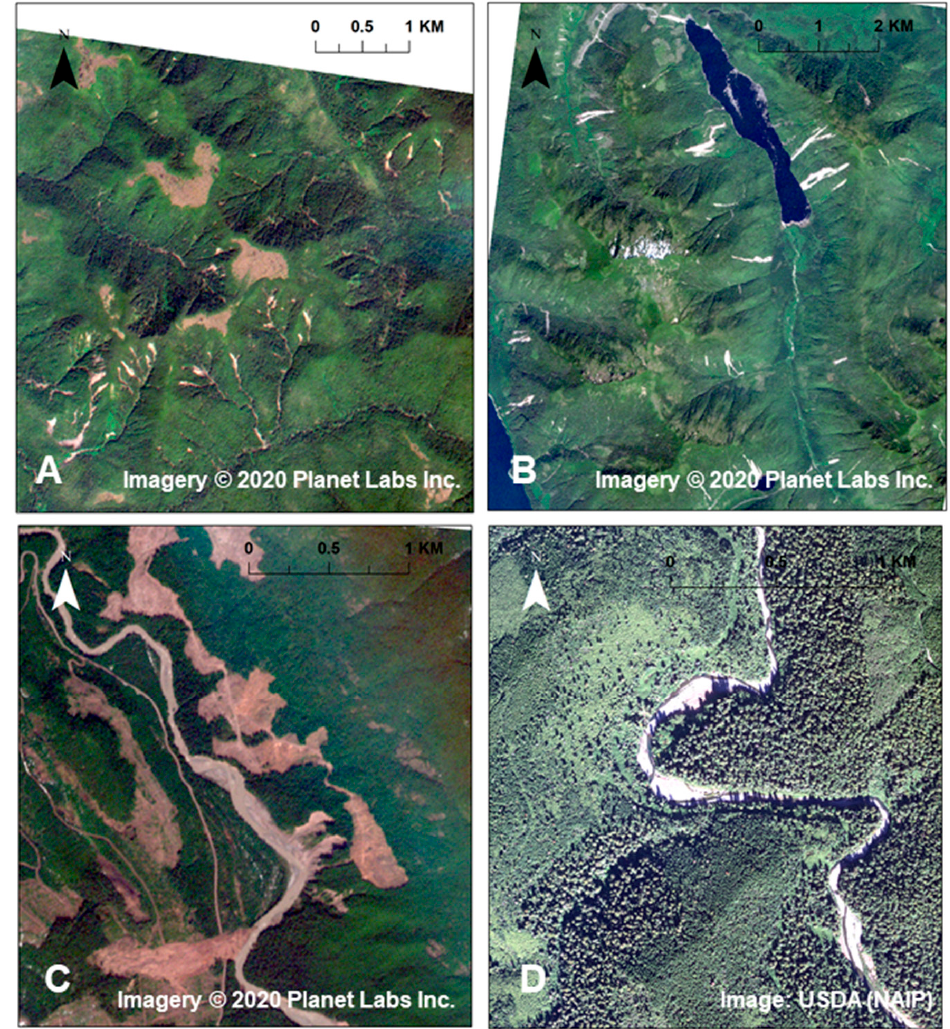
Figure 8. Forest cover disturbance and geomorphic response. ( A , B ): a large number of landslide scars (open slope failures and debris flows) in logged terrain. ( C ) stream-side slope failures generate a sediment pulse—note channel aggradation downstream of the sediment entry points. Flow from the bottom to the top. ( D ) long-term channel recovery from a sediment pulse—note extensive bars indicating abundant sediment storage well over two decades after a large, episodic supply. Flow from the bottom to the top. Image source in ( A – C ): Planet Team